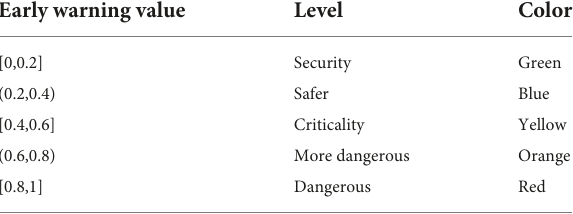
TABLE 3 Five levels of warning signal